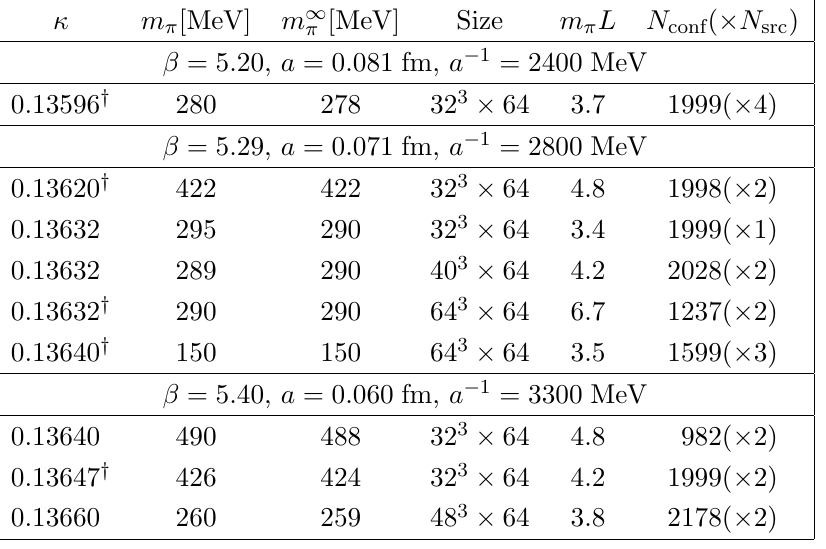
Table 2 . Ensembles used for this work. For each ensemble we give the inverse coupling (cid:12) , the hopping parameter (cid:20) , the pion mass m (cid:25) , the (cid:12)nite volume corrected pion mass m 1 in ref. [22], the lattice size, the value of m (cid:25) L , where L is the spatial lattice extent, the number of con(cid:12)gurations N conf and the number of sources N src used on each con(cid:12)guration. Note that the pion masses have been slightly updated compared to the numbers in ref. [14]. The ensembles